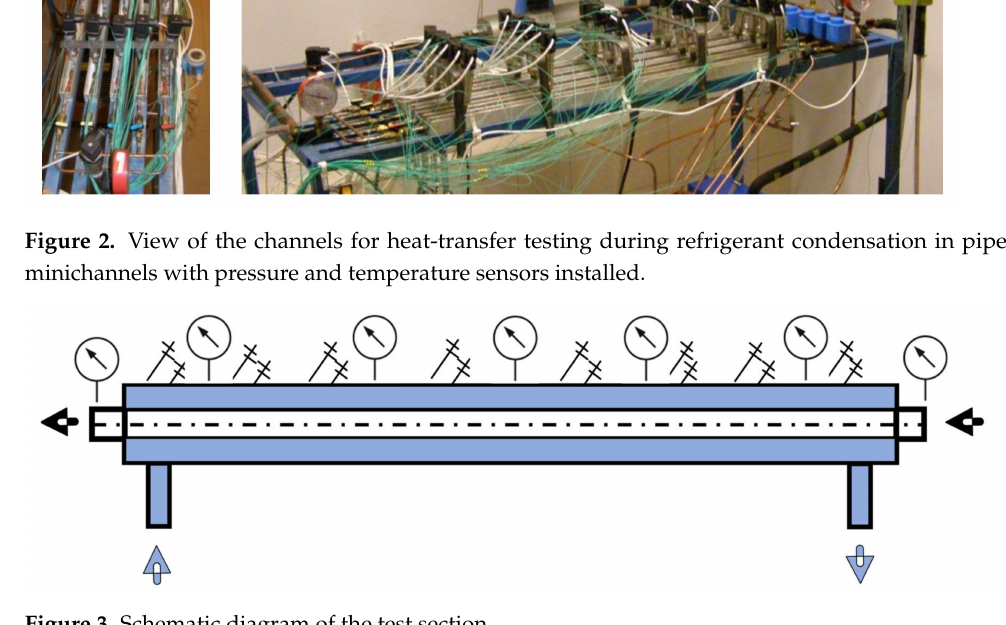
Figure 3. Schematic diagram of the test